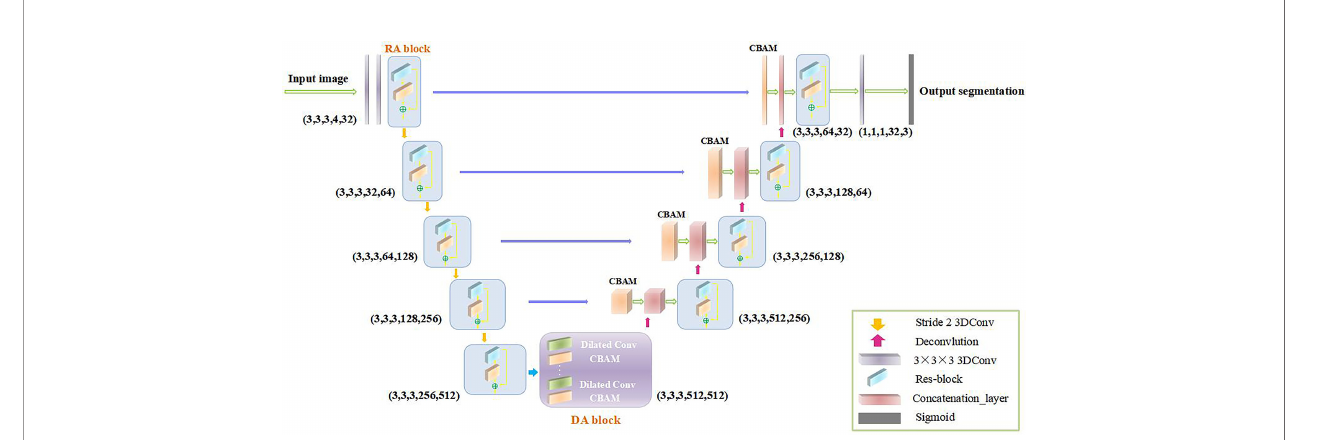
FIGURE 1 | Architecture of the proposed RDAU-Net.